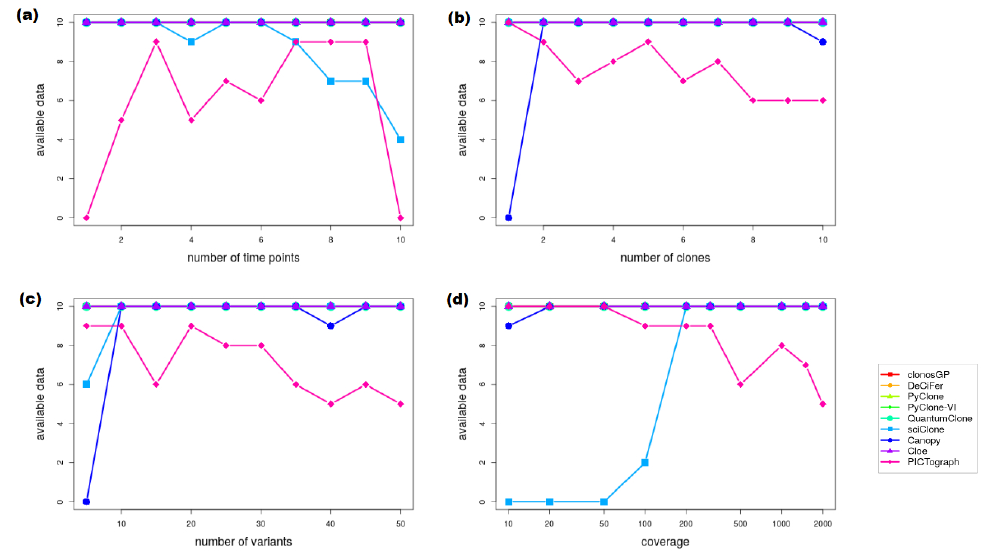
Figure A9. Available clustering output generated using clonosGP, DeCiFer, PyClone, PyClone- VI, QuantumClone, sciClone, Canopy, Cloe, and PICTograph in the absence of CNVs. For each considered number of ( a ) time points, ( b ) clones, ( c ) variants, and ( d ) coverage, 10 patients were simulated.